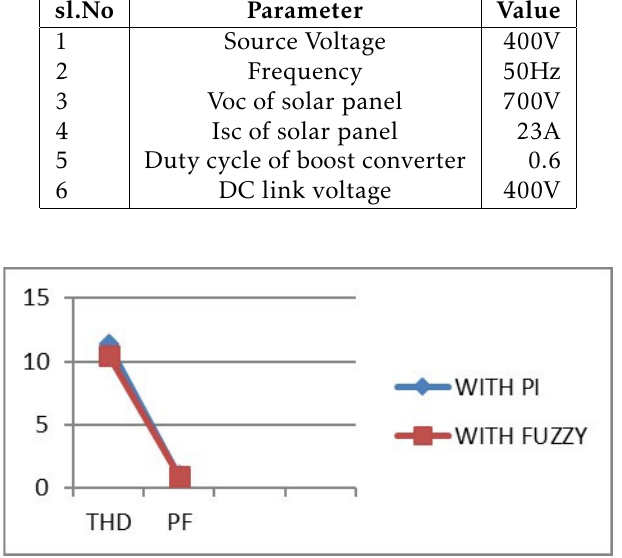
Table 2. Specifications Table of the proposed system sl.No